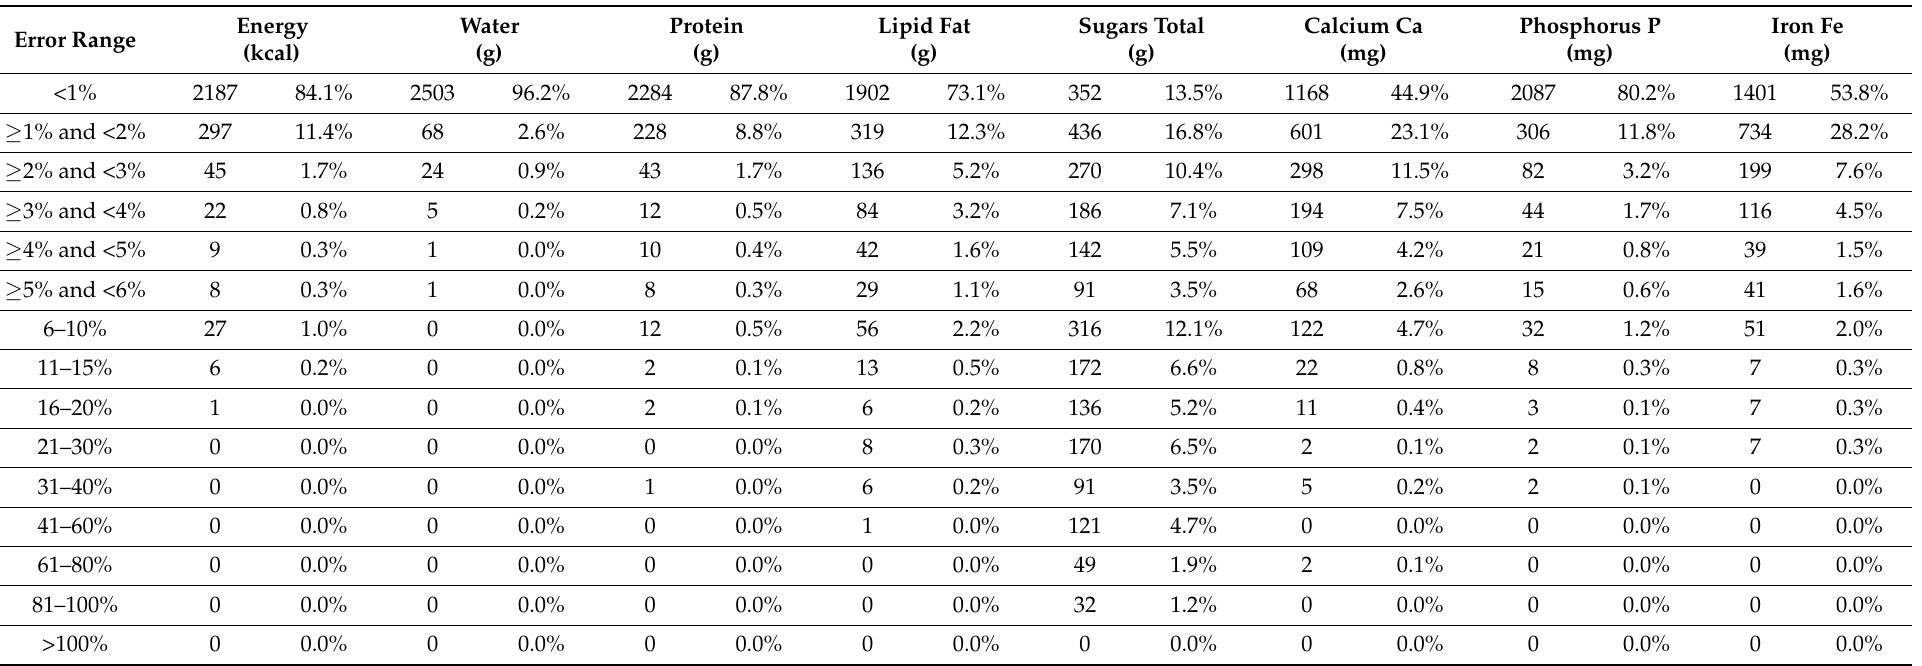
Table 1. Discrepancy comparison table of NNHS analysis with the results of this study in the sum_nutrients_24h